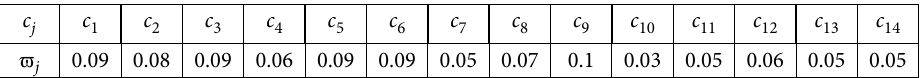
Table 8. The weight of the criterion